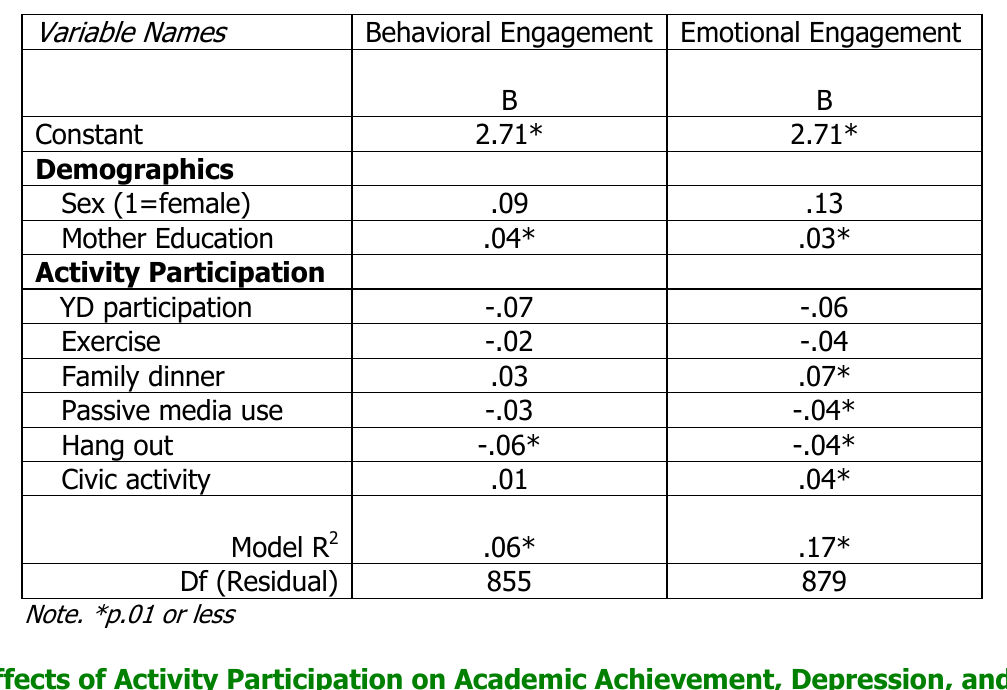
Parameter estimates, approximate p values and goodness-of-fit tests for regression models of the relations between activity participation and school engagement, controlling for the effects